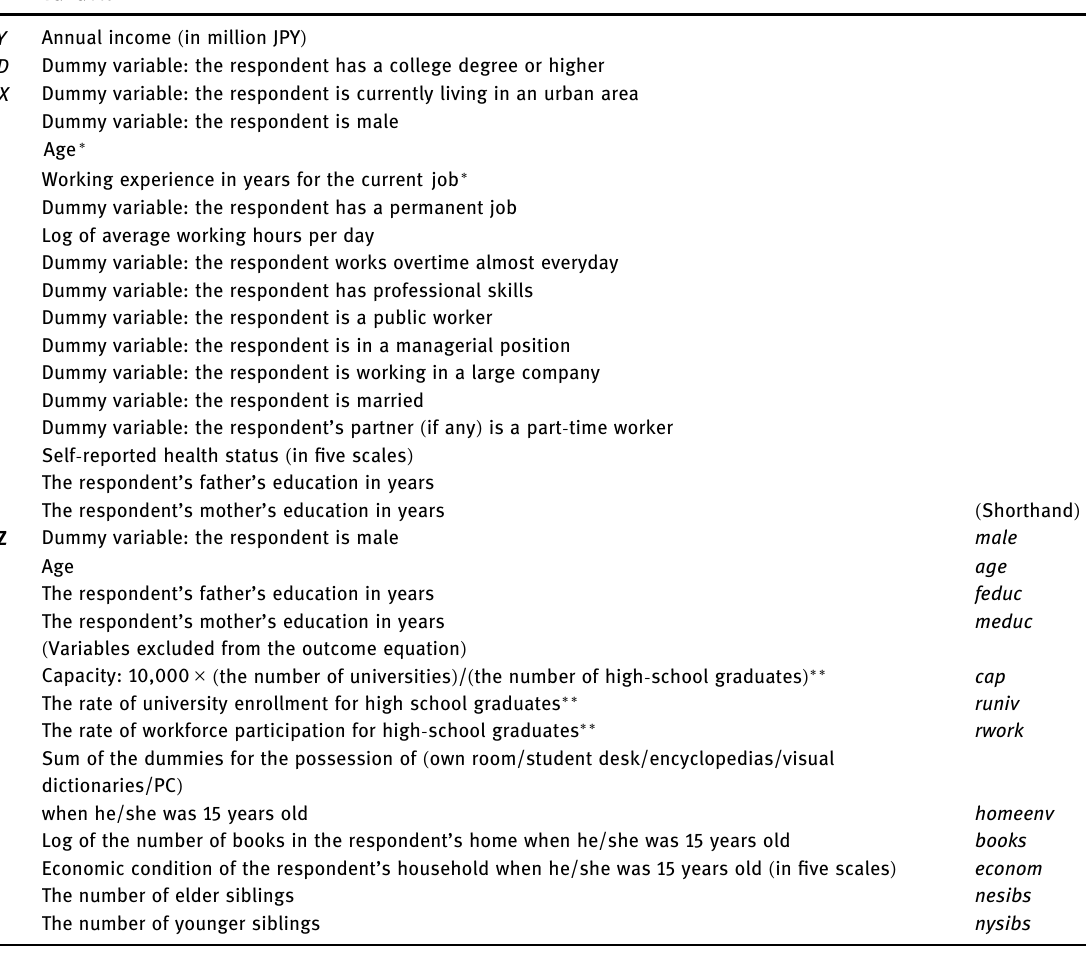
Table 2: Variables used